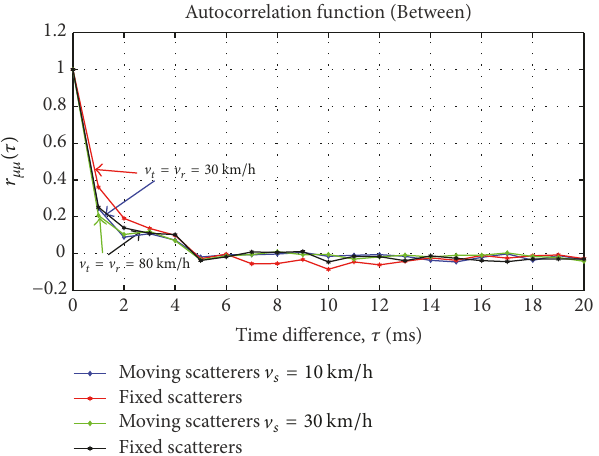
Figure 10: Behavior of ACF 𝑟 𝜇𝜇 (𝜏) presented in Figure 3(b) for V2V scenarios (“Between” central angle: 𝜃 𝑡 = 30 ∘ , 𝜃 𝑟 = 120 ∘ uniform distribution).